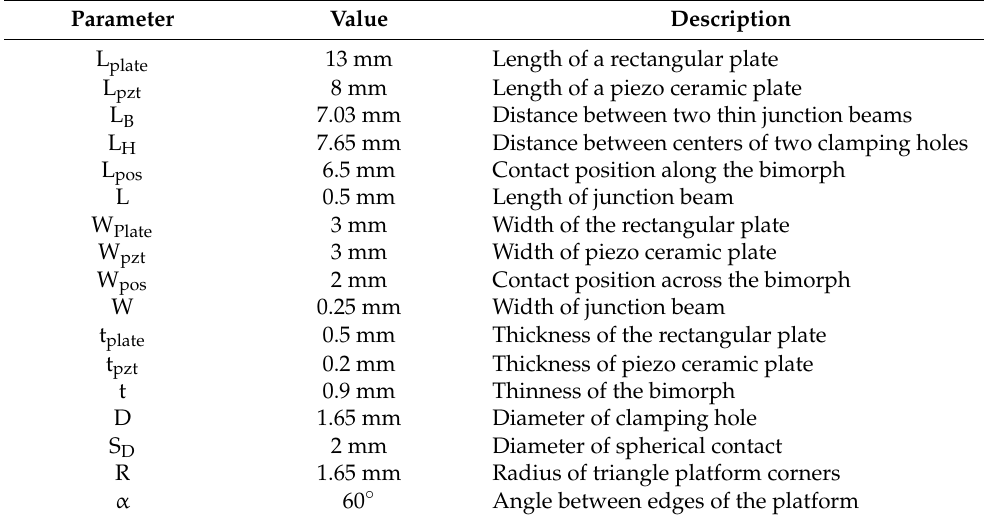
Table 1. Geometrical parameters of the platform.